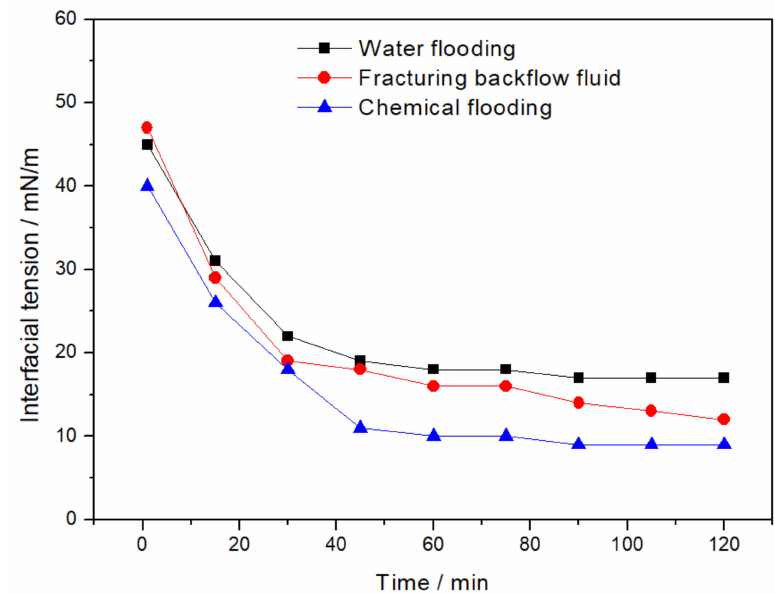
Figure 2. Interfacial tension of WF, CF, and FB emulsion.